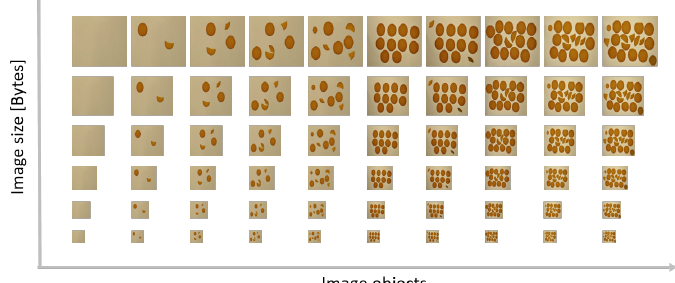
Figure 4. Sixty images of the 100-image